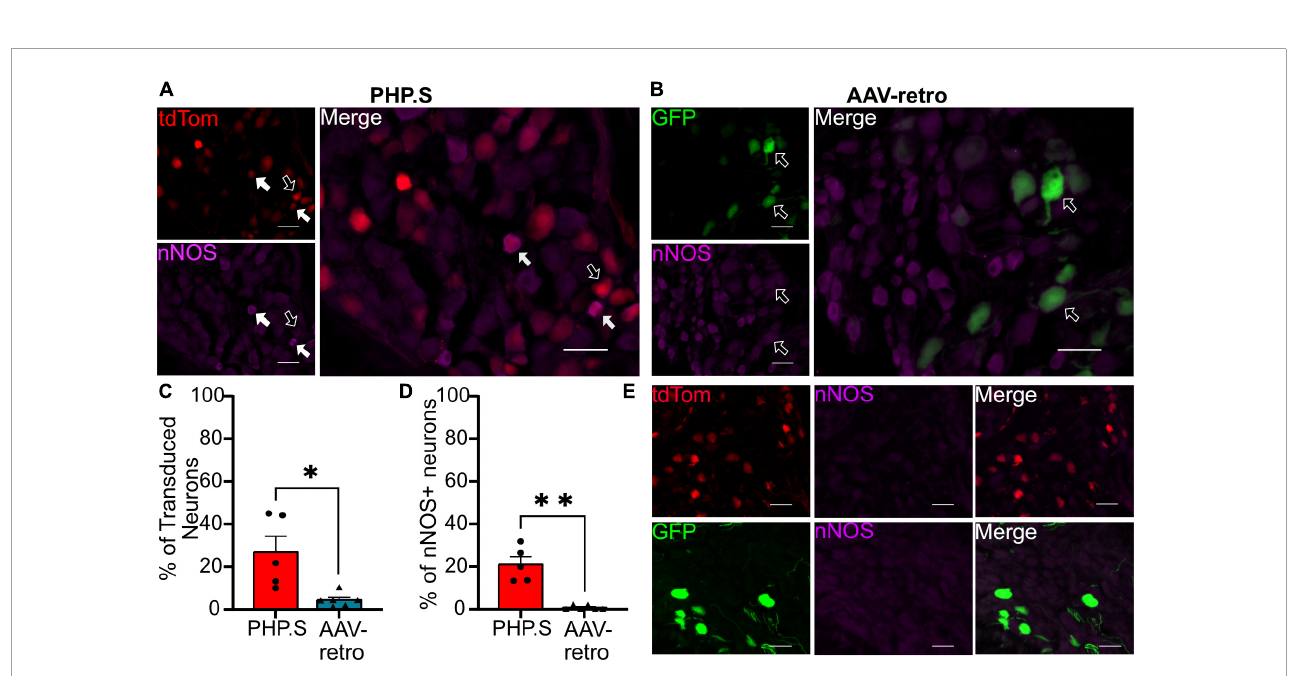
FIGURE10 PHP.S shows tropism for parasympathetic neurons over adeno-associated viruses (AAV)-retro in pelvic ganglia. (A) Representative images of tdTomato expression colocalizing with neuronal nitric oxide synthase (nNOS) + neurons in pelvic ganglia from PHP.S-injected rats (scale bar, 50 µ m). (B) Representative images of GFP expression colocalizing with nNOS + neurons in pelvic ganglia from AAV-retro-injected rats (scale bar, 50 µ m). (C) The percent of transduced neurons that were nNOS +, Welch’s t -test was used to compare PHP.S ( n = 5) and AAV-retro ( n = 6) because the data set had unequal variances ( ∗ p = 0.0394). (D) Percent of nNOS + neurons that were transduced. Mann–Whitney test was used to compare PHP.S ( n = 5) and AAV-retro ( n = 6) because the data had unequal variances and did not reach normalcy ( ∗ p = 0.0043 and ∗∗ p = 0.0043). (E) Images of pelvic ganglia tissue from rats injected with PHP.S (top) or AAV-retro (bottom) with secondary antibody staining only in the corresponding fluorophore used for nNOS in experimental tissue. White arrows indicate neurons with colocalization; black arrow with a white outline indicates viral transduced without